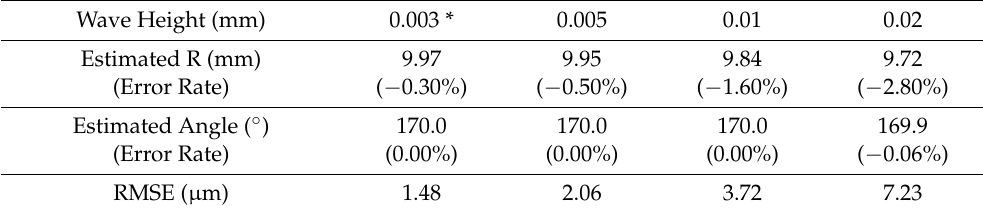
Table 4. Estimated radii and angles for different heights of the sine wave. Reference value is marked with an asterisk (*).